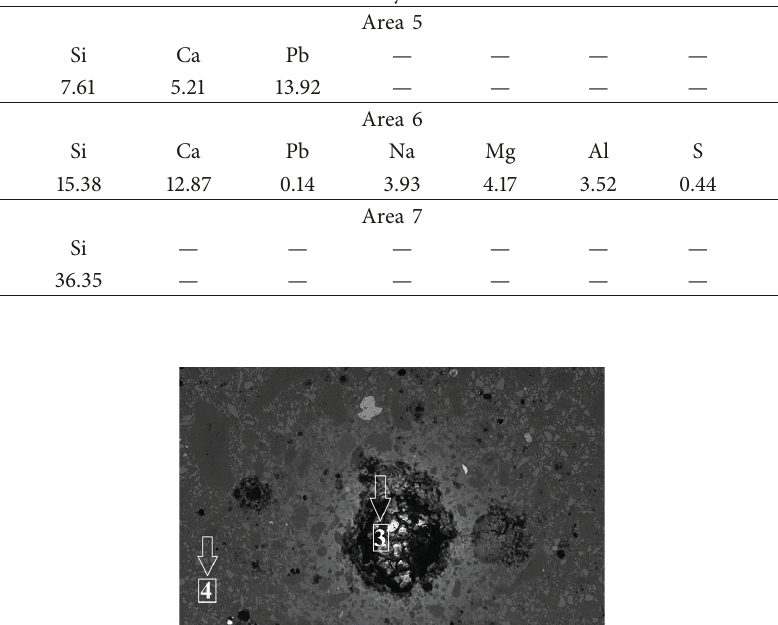
Figure 5: The microstructure of M2 Table 9: EDS analysis of M2 matrix.